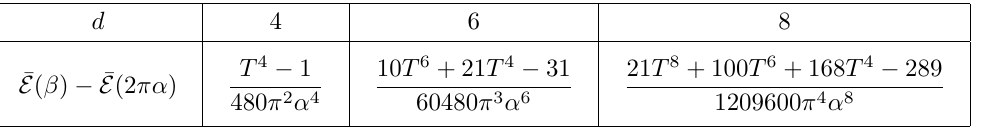
Table 1 . Thermal energy density of a scalar (cid:12)eld conformally coupled to the hyperbolic background R (cid:2) H d (cid:0) 1 , written in terms of the dimensionless temperature T = 2 (cid:25)(cid:11)=(cid:12) . As required, all the expressions vanish for T =